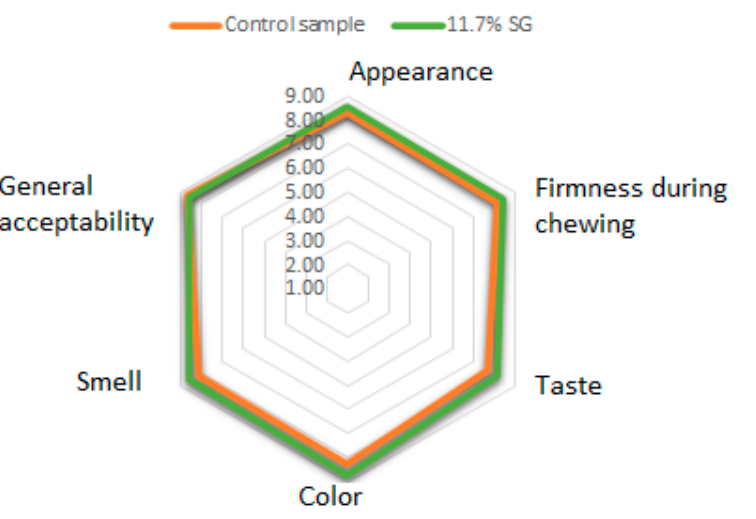
Figure 3. Sensory scores for pasta.